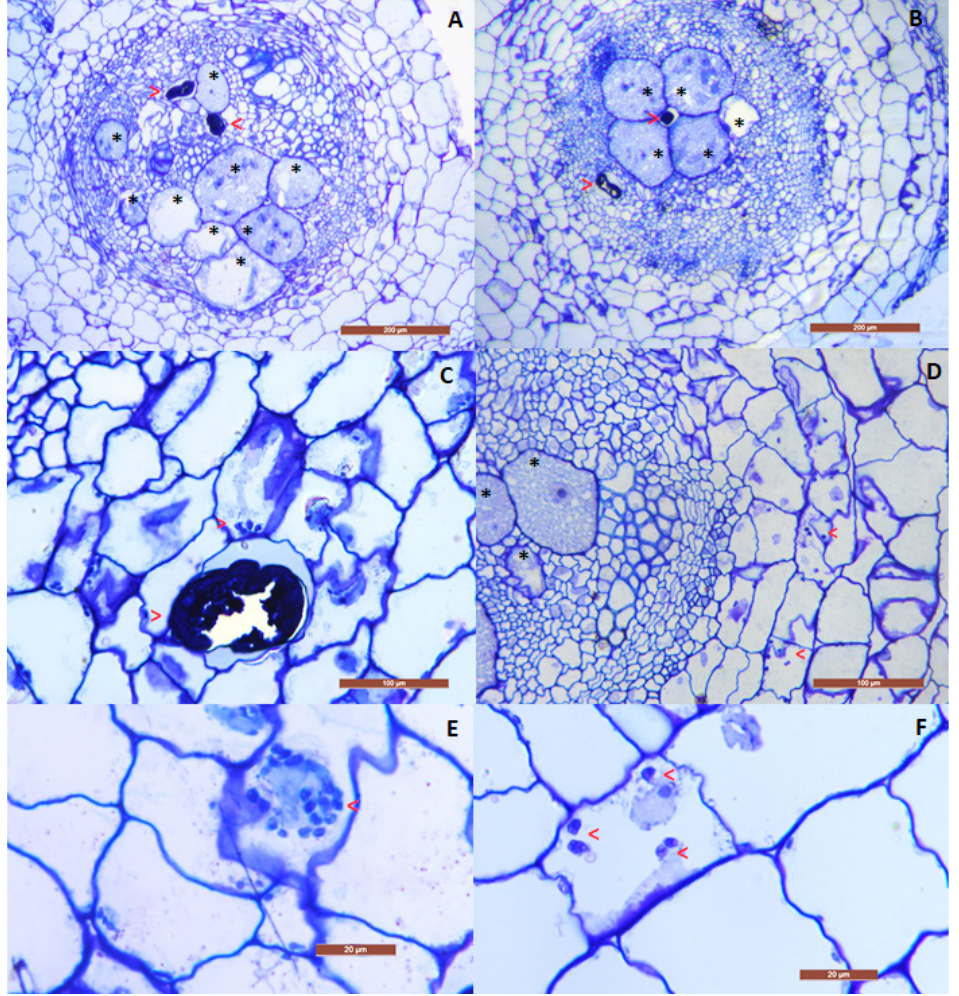
Figure 1. Sections from galls induced by M. incognita in the roots of tomato accessions MRT ( A ) and PLZ ( B ), showing alternated xylematic and phloematic arcs and feeding sites. Chlamydospores and hyphae of P. chlamydosporia occurred in the cortical area of both MRT ( C , E ) and PLZ ( D , F ) roots. Asterisks show giant cells, and arrows indicate nematodes and chlamydospores. Scale bars: ( A , B ) = 200 µm; ( C , D ) = 100 µm; ( E , F ) = 20 µm.